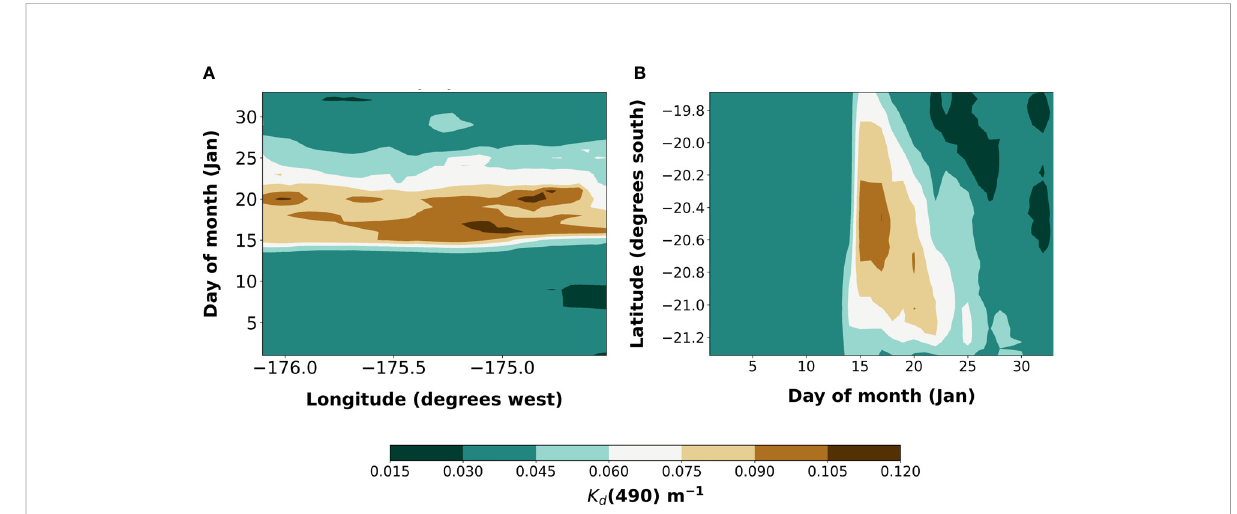
FIGURE 4 Hovmöller plots of CMEMS K d (490) (in m -1 ) for the month of January 2022 representing the (A) latitudinal transect along 175.45°W, and (B) longitudinal transect along 20.73°S within the discolored water patch (location illustrated in Figure 1C). Values are represented from 0.015 to 0.120 m -1 for more